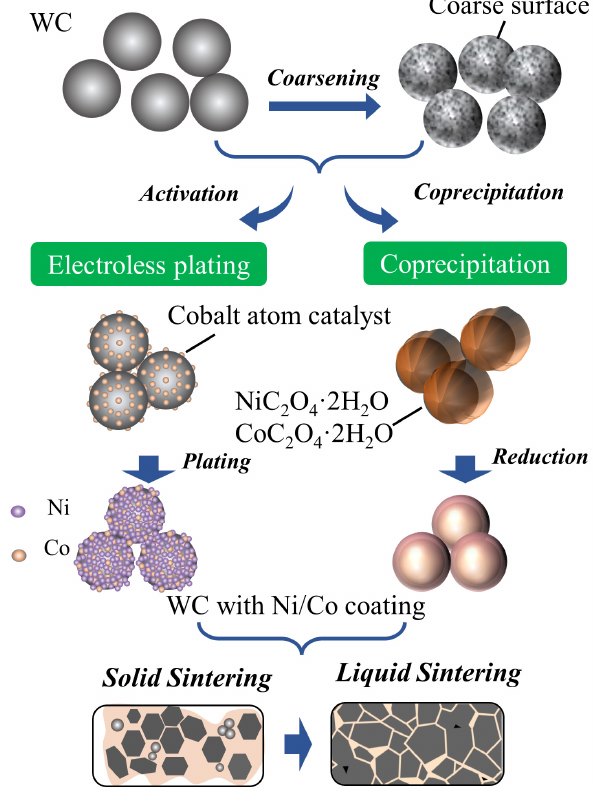
Figure 1. Preparation of WC-Ni/Co composite powder and densification.